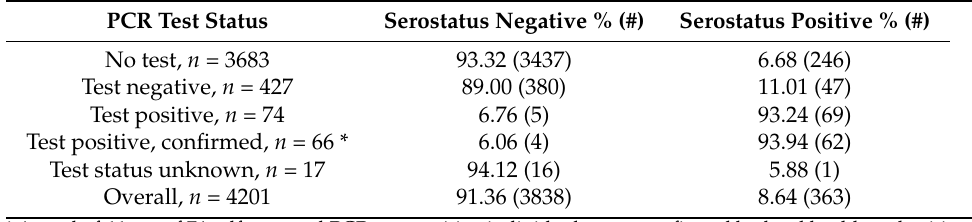
Table 2. PCR-test self-report and confirmed positive PCR vs.